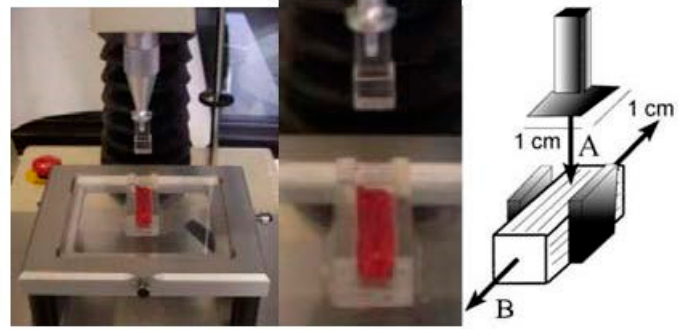
Figure A1. Direction of the applied force ( A ) and the sample deformation ( B ) in the compression test.